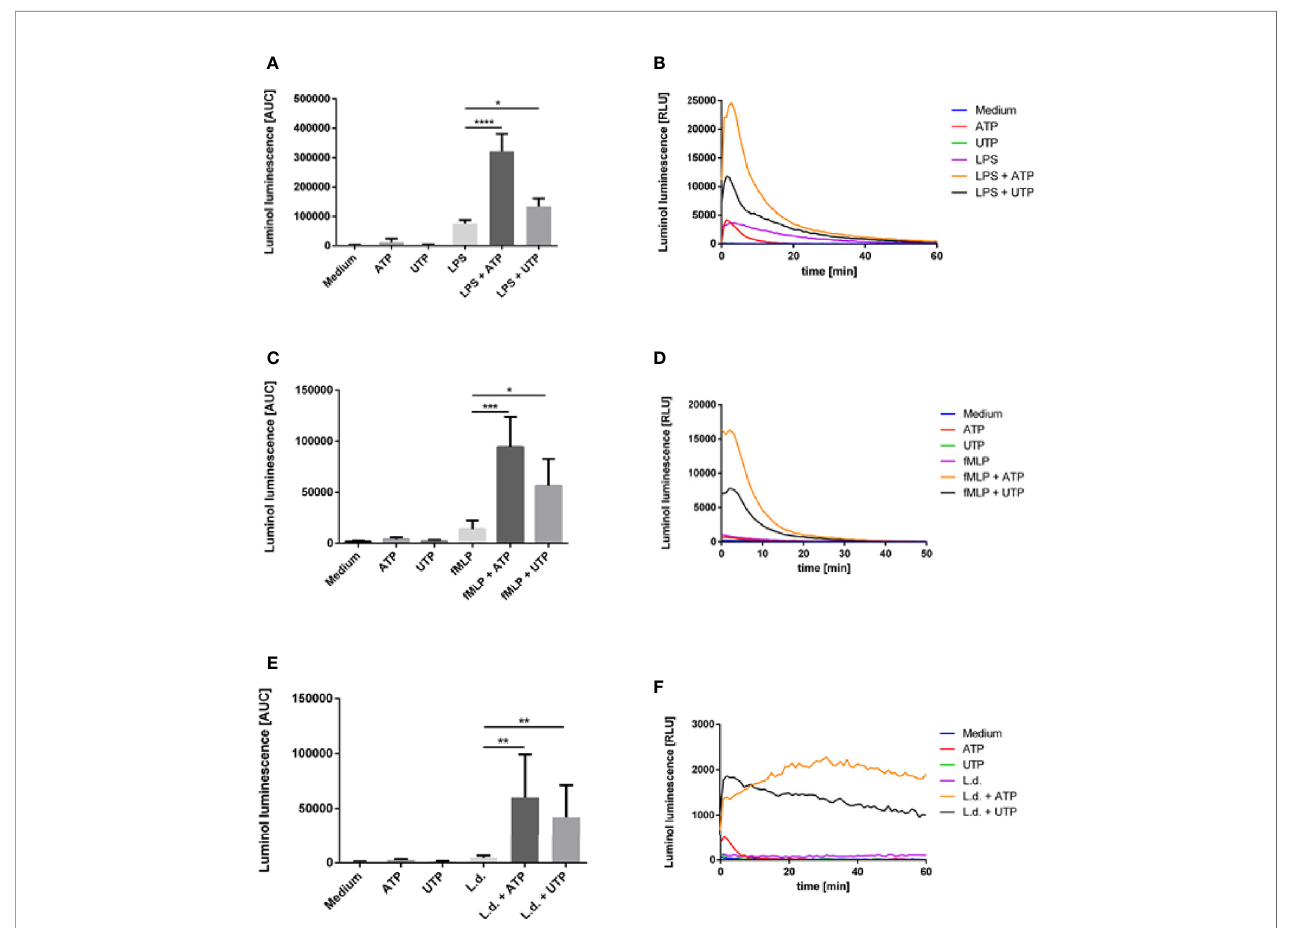
FIGURE 2 | The effect of extracellular ATP and UTP on the ROS production by neutrophils. Neutrophils were treated with (A, B) ATP, UTP, LPS and the combination of LPS with ATP and UTP; (C, D) ATP, UTP, fMLP and the combination of fMLP with ATP and UTP or (E, F) ATP, UTP, coincubated with L. donovani promastigotes or co-incubated with L. donovani promastigotes in the presence of ATP or UTP. Production of total ROS was measured by luminol luminescence. (B, D, F) Representative kinetic curves of ROS production by neutrophils. (A, C, E) ROS production shown by calculating the area under the curve (AUC) values. Statistical analysis by ordinary one-way ANOVA with a post hoc Turkey ’ s test. Asterisks above the bars indicate signi fi cance compared to untreated cells. n=3, *p ≤ 0,05, **p ≤ 0,01, ***p ≤ 0,001, ****p ≤